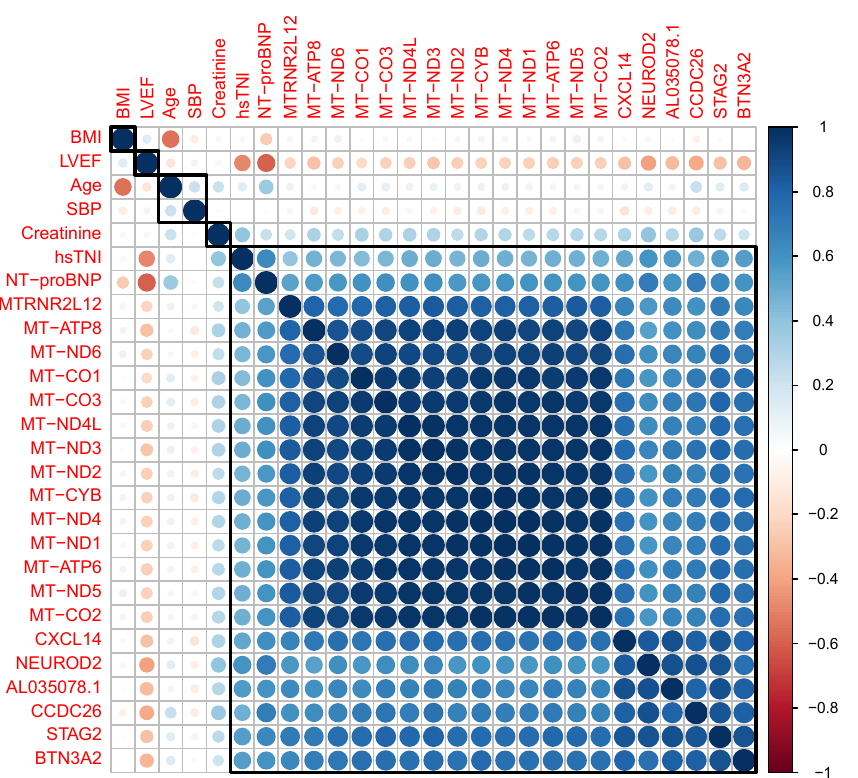
Figure 1. Correlation matrix showing the relationship between the 20 most differentially expressed transcripts and selected clinical factors in patients and controls. Hierarchical clustering indicated a strong correlation between transcripts, particularly those originating from the mitochondrial genome (i.e., all those prefaced by ‘MT’). All transcripts were moderately correlated with the cardiac biomarkers NT-proBNP and hsTNI, but not with age, BMI or SBP. The strength and direction of each association is indicated by circle size (larger circles indicate stronger correlations); blue indicates positive correlations; red indicates negative correlations: BMI, body mass index; hsTNI, high sensitivity troponin I; LVEF, left ventricular ejection fraction; NT-proBNP, amino-terminal pro B-type natriuretic peptide; SBP, systolic blood pressure.